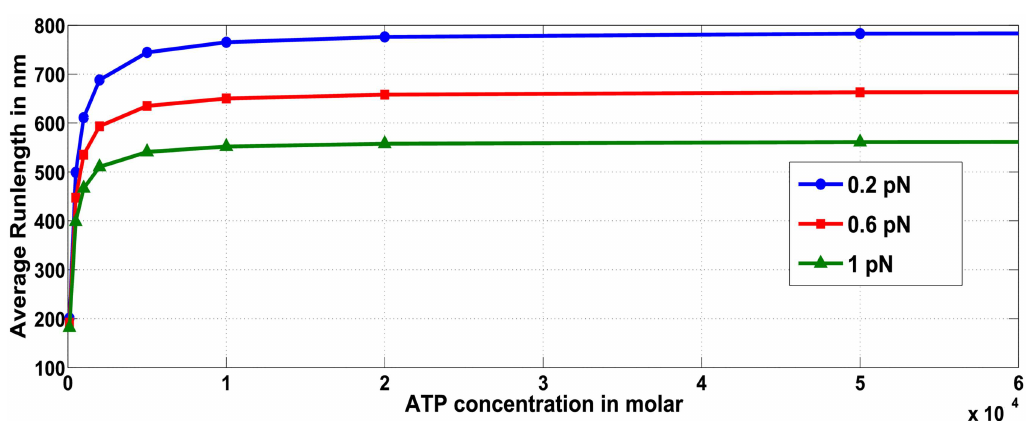
Fig 12. Effect of ATP concentration on run-length for ensemble containing one wild-type motor, for various hindering load forces on the cargo.